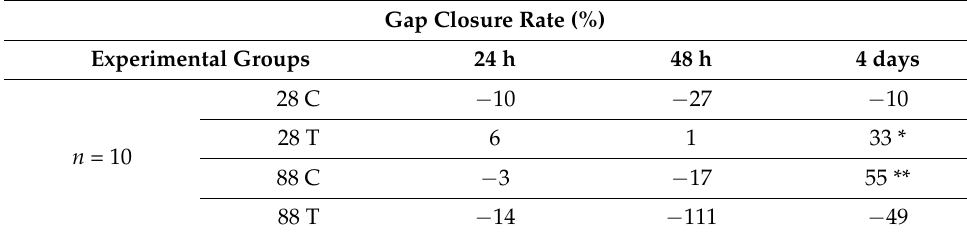
Table 3. Vectoral gap closure rates of all sample groups. The numbers 28 and 88 stand for the age of the donor which the dermal fibroblast cells were harvested from. C = Control Group and T = Training Group. Negative values indicate an increase in gap size and vice versa (* p < 0.05, significance compared to initial; ** p < 0.01, significance compared to